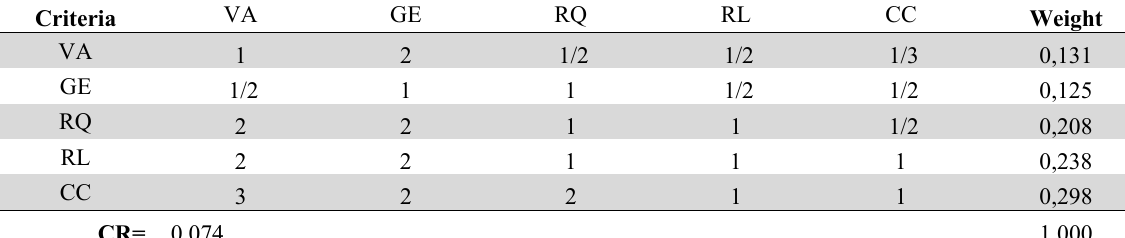
Pairwise comparison matrix aggregation for Institutional Vulnerability.